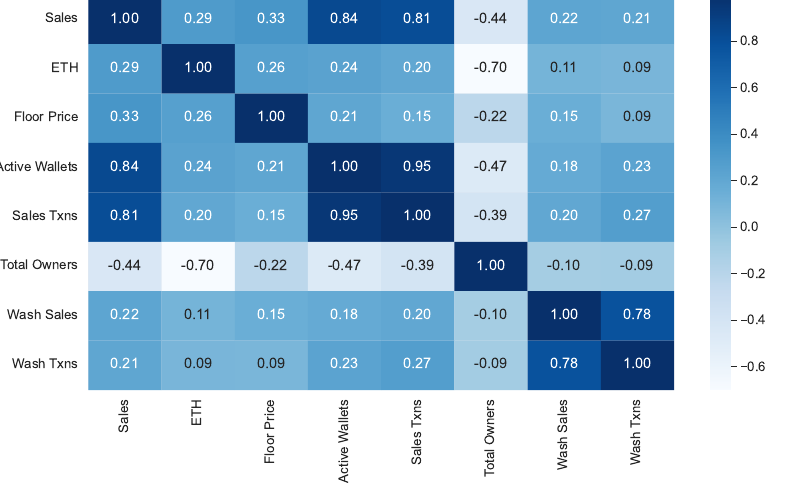
Figure 2. Values of the Pearson coefficient averaged on all available NFT